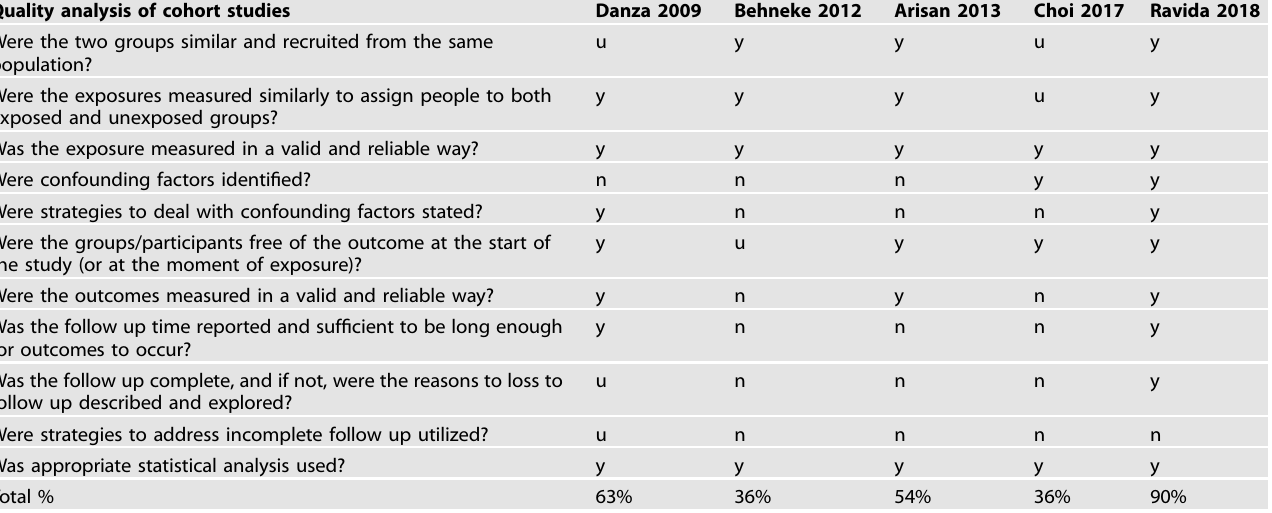
Table 3. Individual risk of bias assessment for cohort studies: review authors ’ judgements about each risk of bias factor among the selected studies.